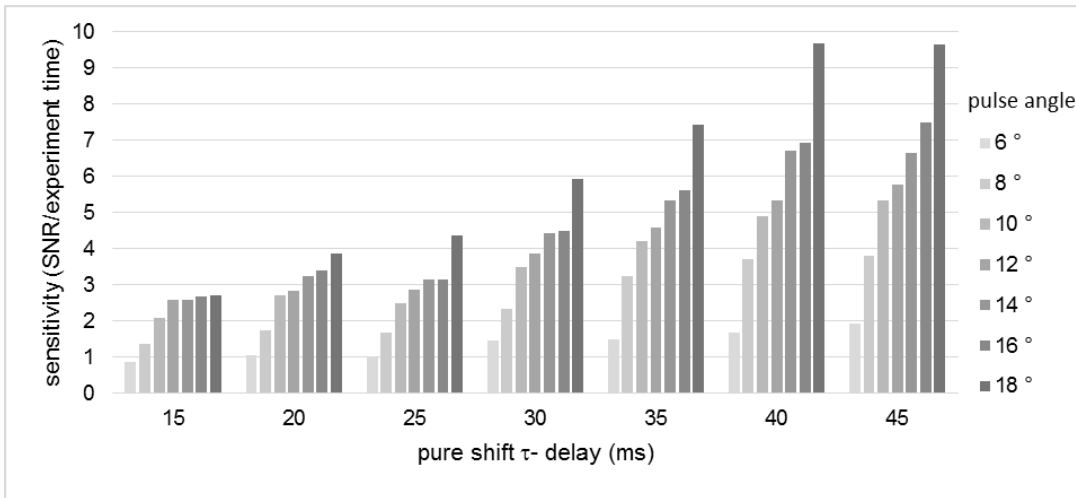
Figure 3. Effect of the variation of pulse angle and τPS on the sensitivity (given as signal to noise ratio (SNR) per experiment time) of the PSYCHE spectra